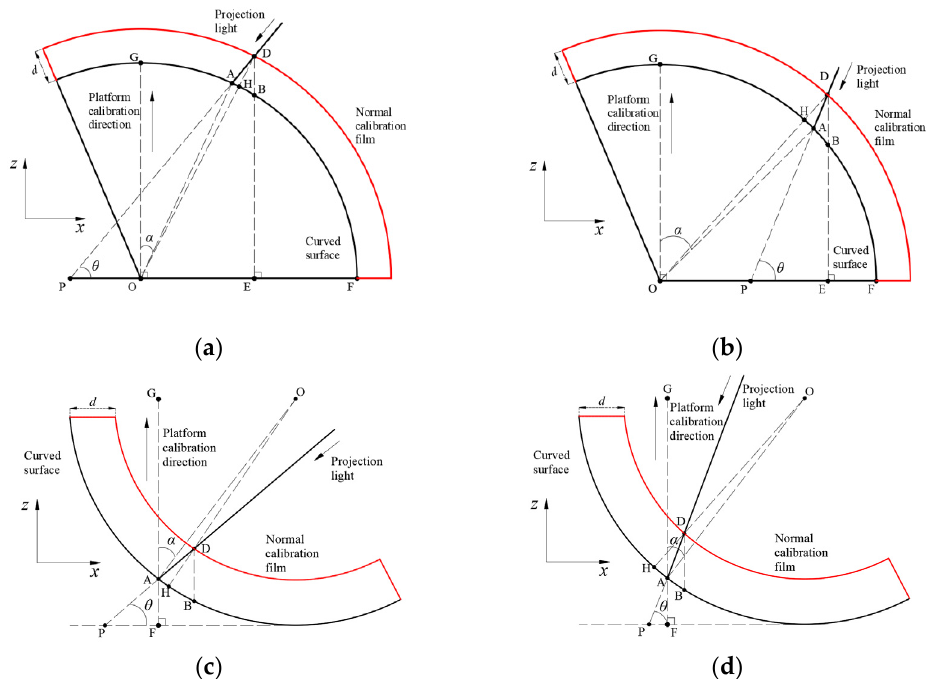
Figure 3. Typical geometric configurations of the DIP measurement on curved surface: ( a ) 90° − α ≥ θ (convex surface); ( b ) 90° − α ≤ θ (convex surface); ( c ) 90° − α ≥ θ (concave surface); ( d ) 90° −α ≤ θ (concave surface)